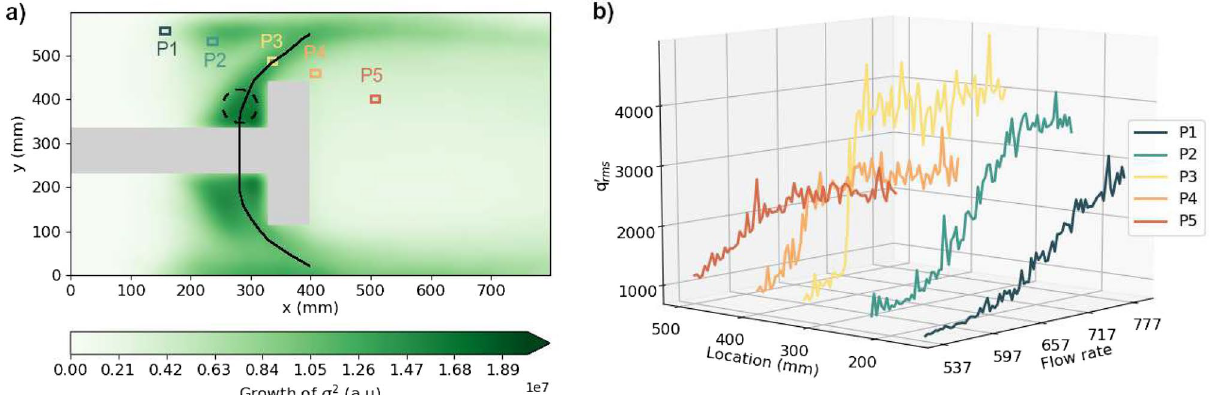
Figure 2. ( a ) The growth of σ 2 (variance of fluctuations) of spatially resolved ˙ q ′ , calculated as the difference of σ 2 at ˙ m air = 600 SLPM and ˙ m air = 650 SLPM for the BL bluff body. The growth of σ 2 is high at certain regions, marked a C-shaped black curve. Colored squares indicate the locations that we utilize to plot the local ˙ q ′ rms in ( b ). The dashed black circle represents the region Z 2 . ( b ) The local ˙ q ′ rms at P1, P2, P3, P4 and P5 at different flow rates. As the control parameter is varied, a spatiotemporal pattern can be observed in the transition from S CN to S TI with a gradual transition at P1, an abrupt transition at P3 and a disappearance of the abruptness of the transition at